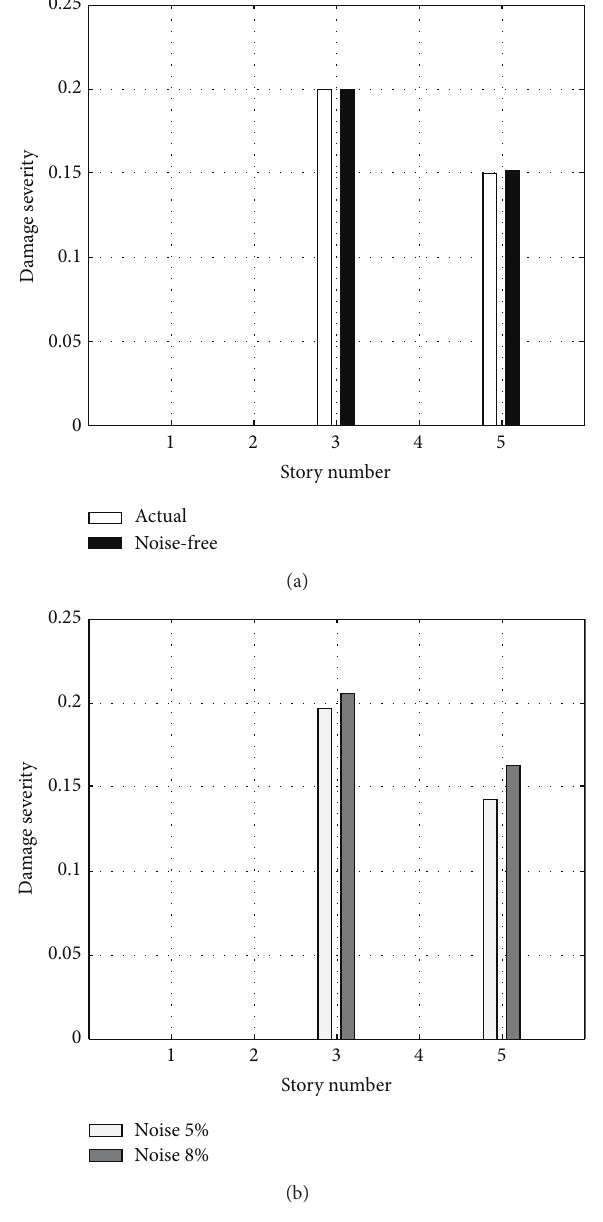
Figure 5: Damage detection results in the five-story shear frame for scenario III. Table 3: The properties of the ten-story shear frame.